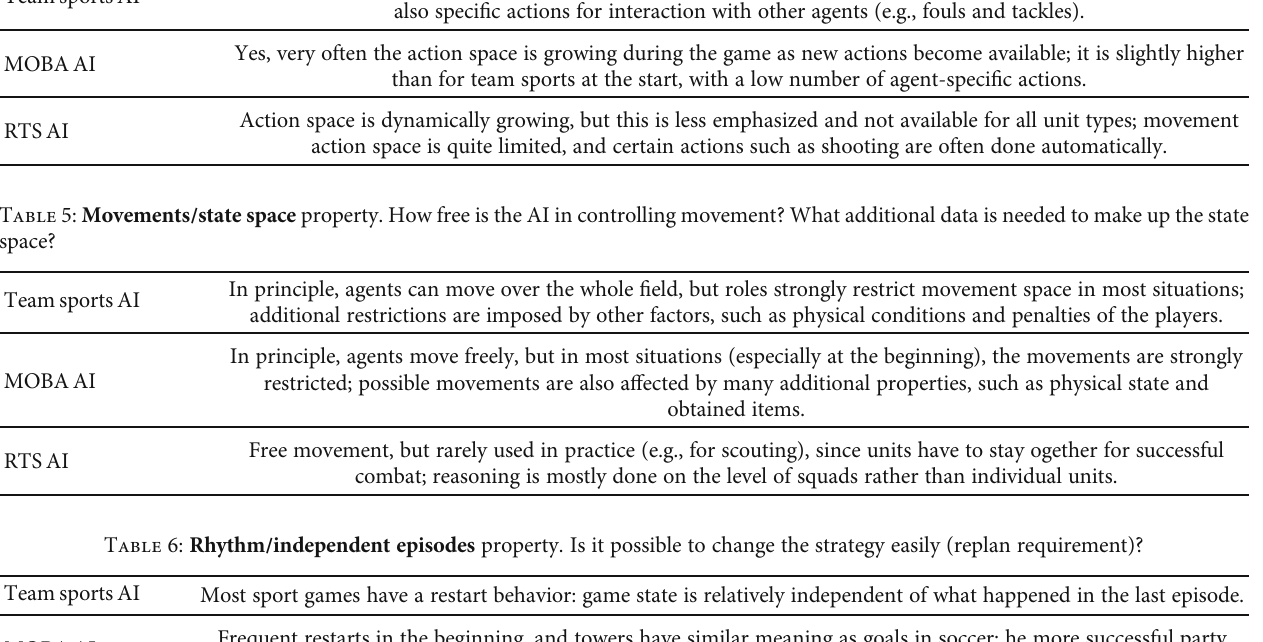
Table 4: Action space property. Does the agent have many microlevel actions available? Team sportsAI